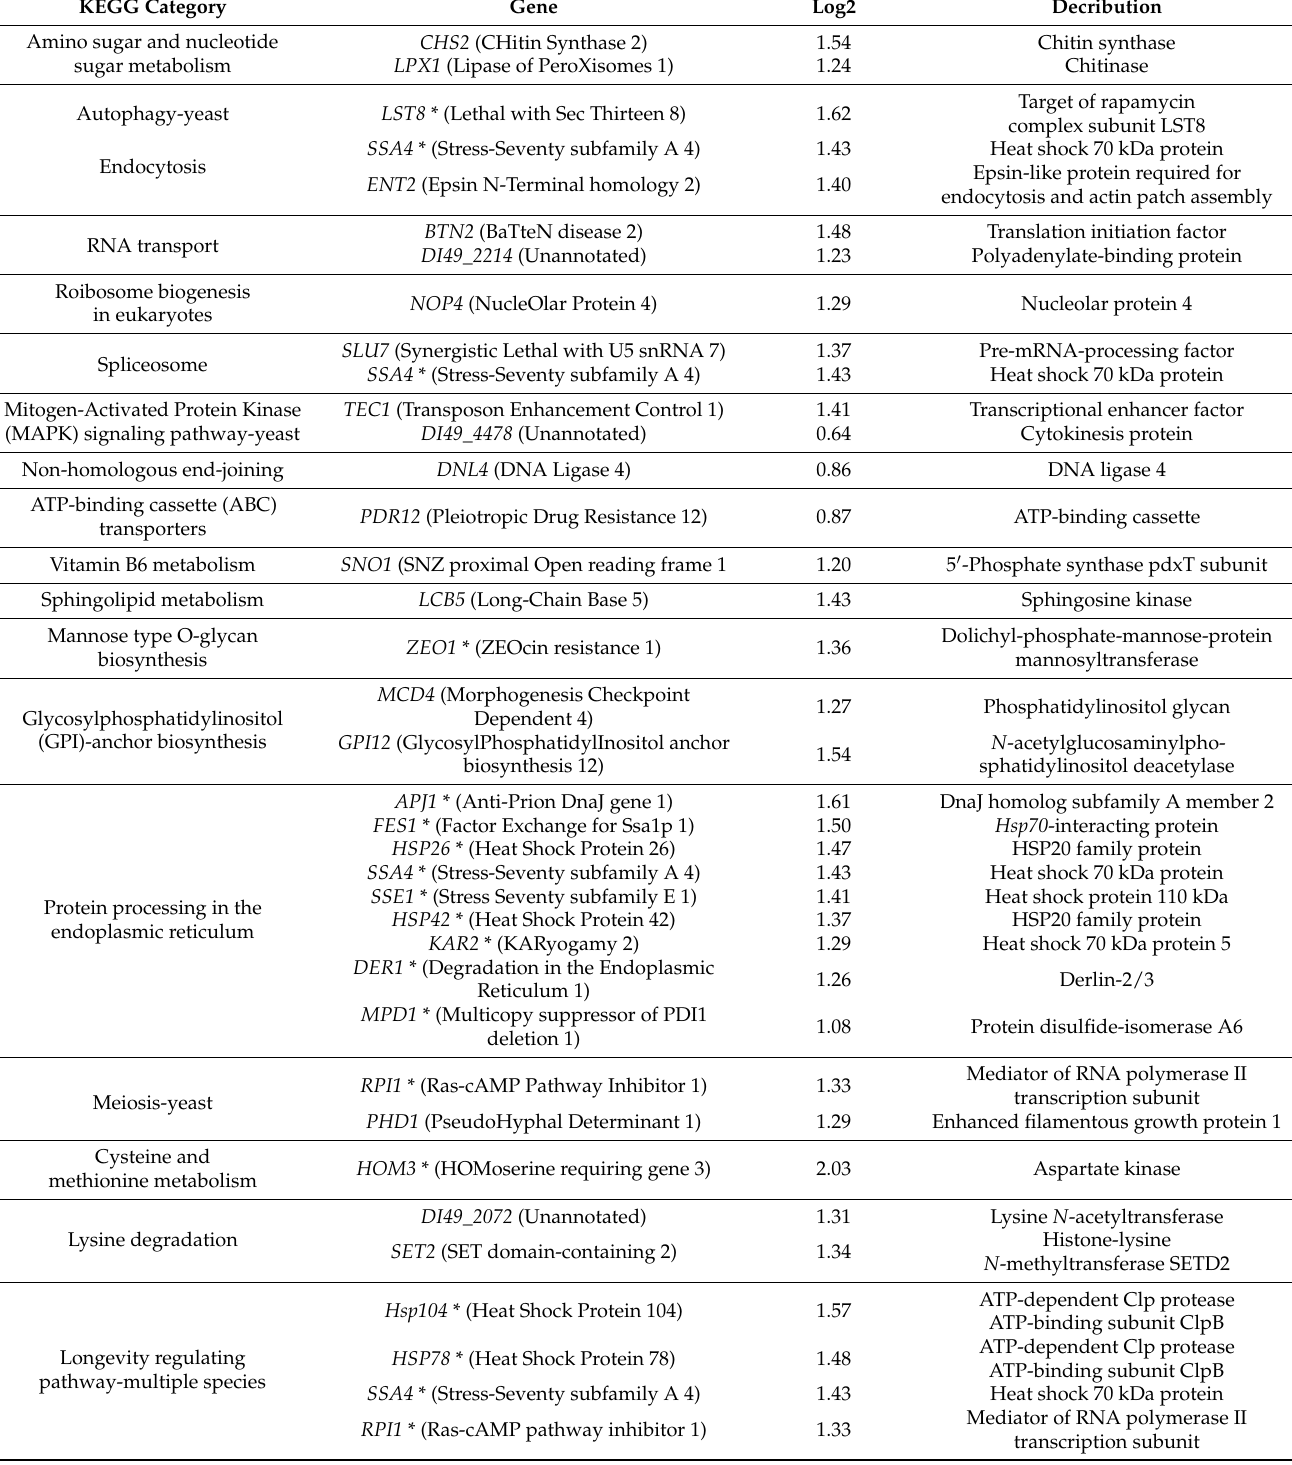
Table 4. The gene expression levels of A9- MET4 compared to the starting strain